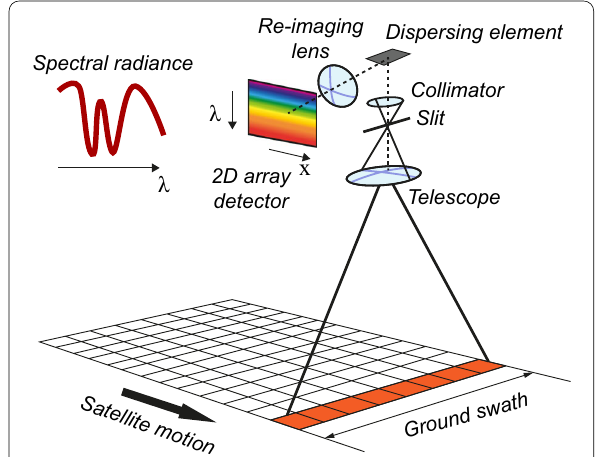
Fig. 4 Scheme for a push‑broom